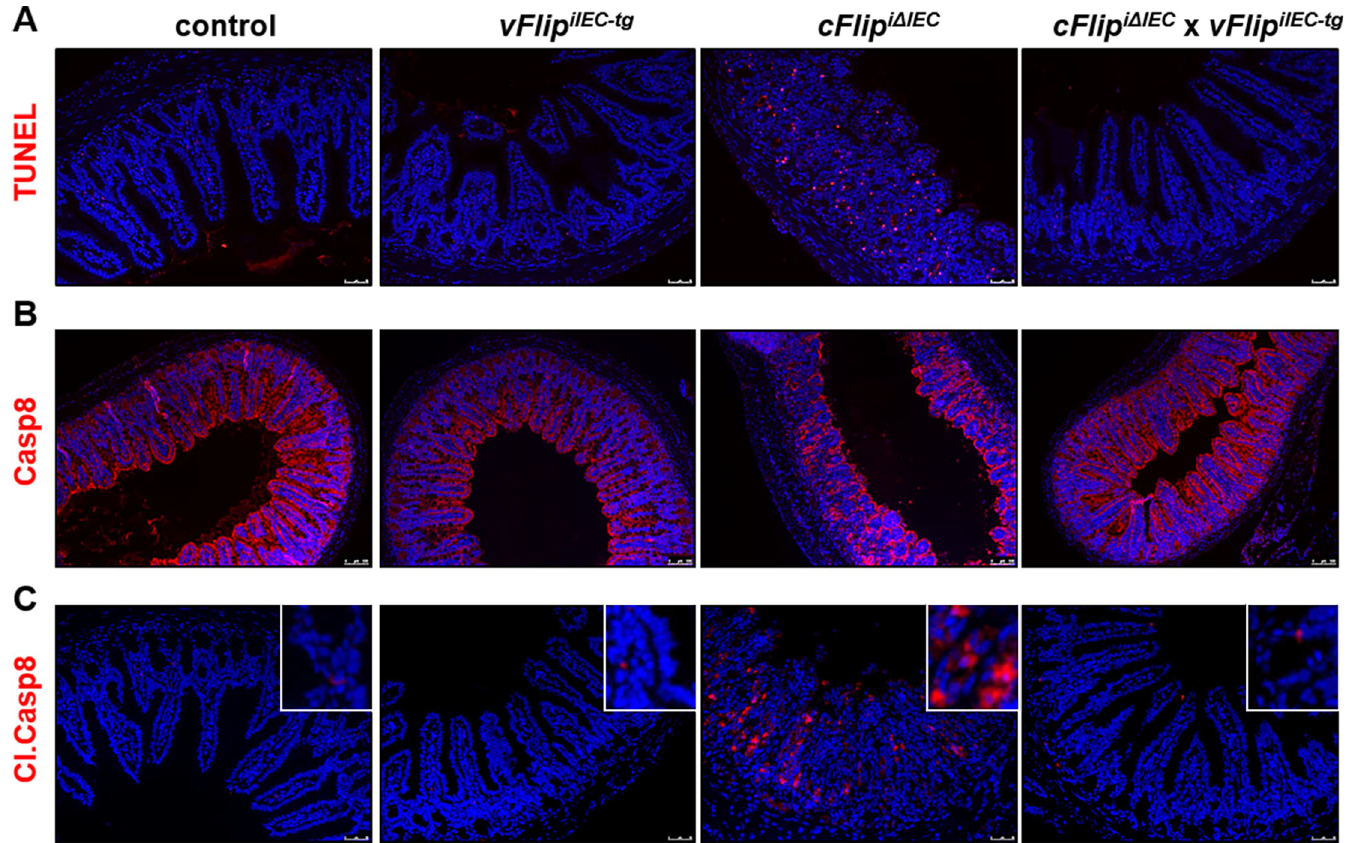
Fig 4. Epithelial cell death induced by cFlip deletion is counteracted by vFLIP in vivo . Representative pictures of (A) TUNEL, (B) Caspase-8 and (C) Cl. Caspase-8 stainings (all red) on cross-sections of indicated mice. Nuclei were counterstained with Hoechst 33342. Scale bar upper and lower panel 50 μ m, middle panel 100 μ m.